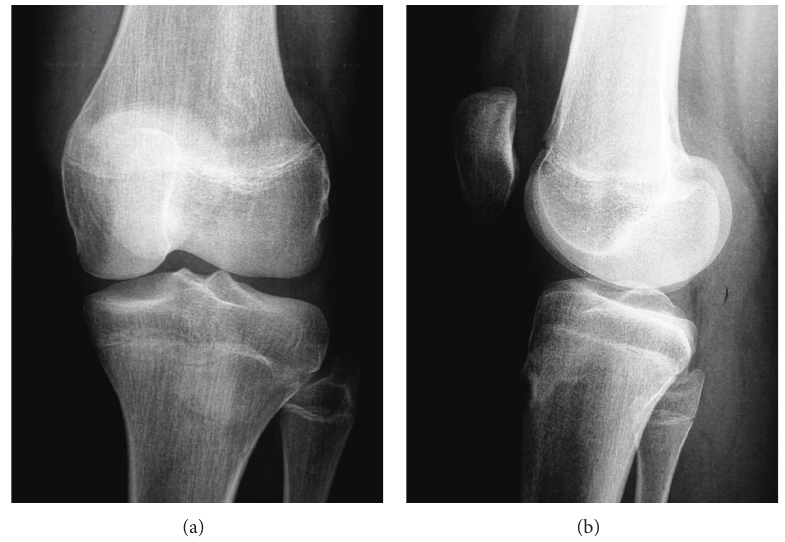
Figure 1: Radiograph of the patient’s left knee in anteroposterior (a) and lateral (b) view.